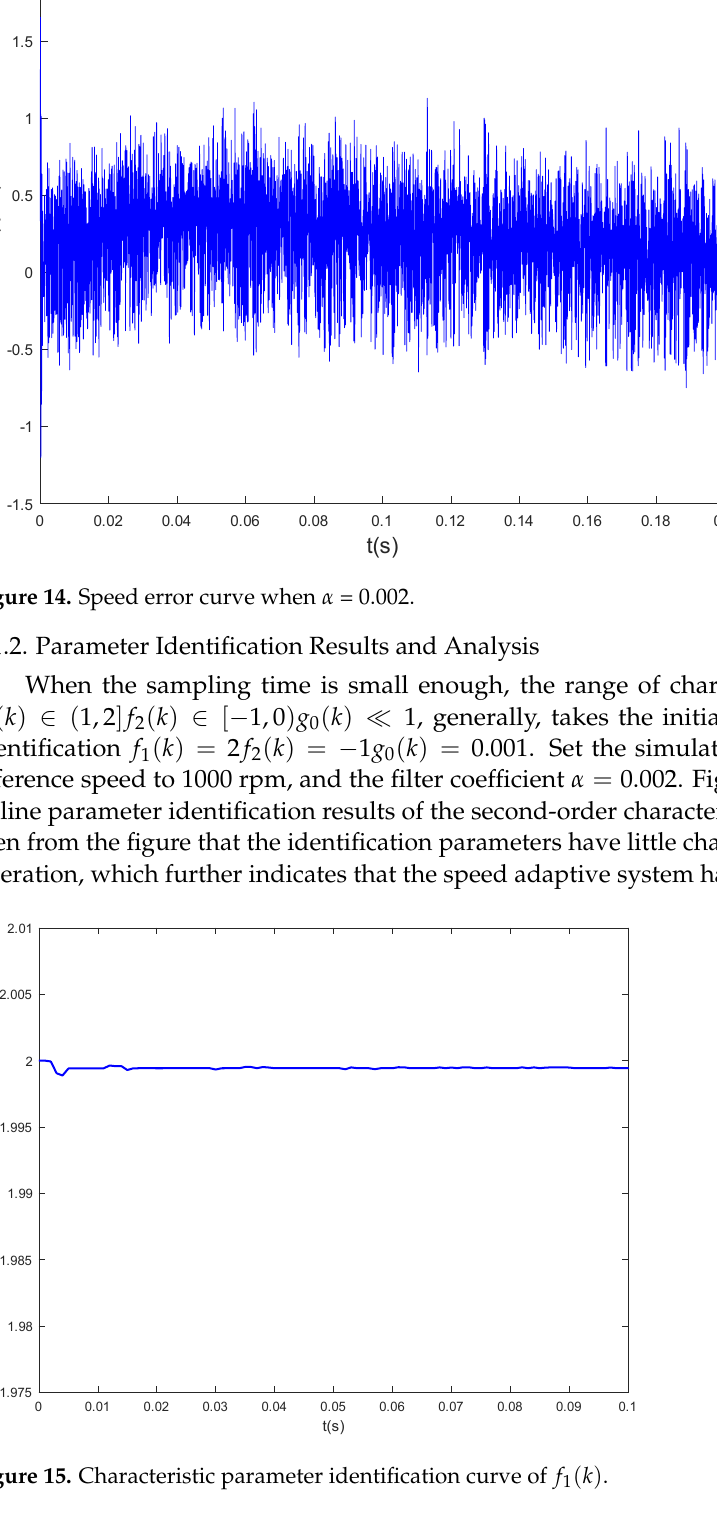
Figure 16. Characteristic parameter identification curve of